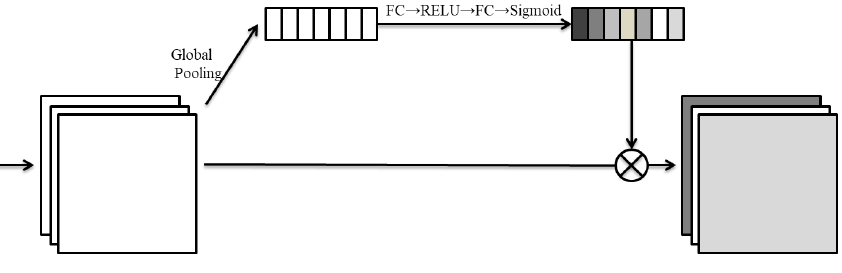
Figure 2. Channel Attention